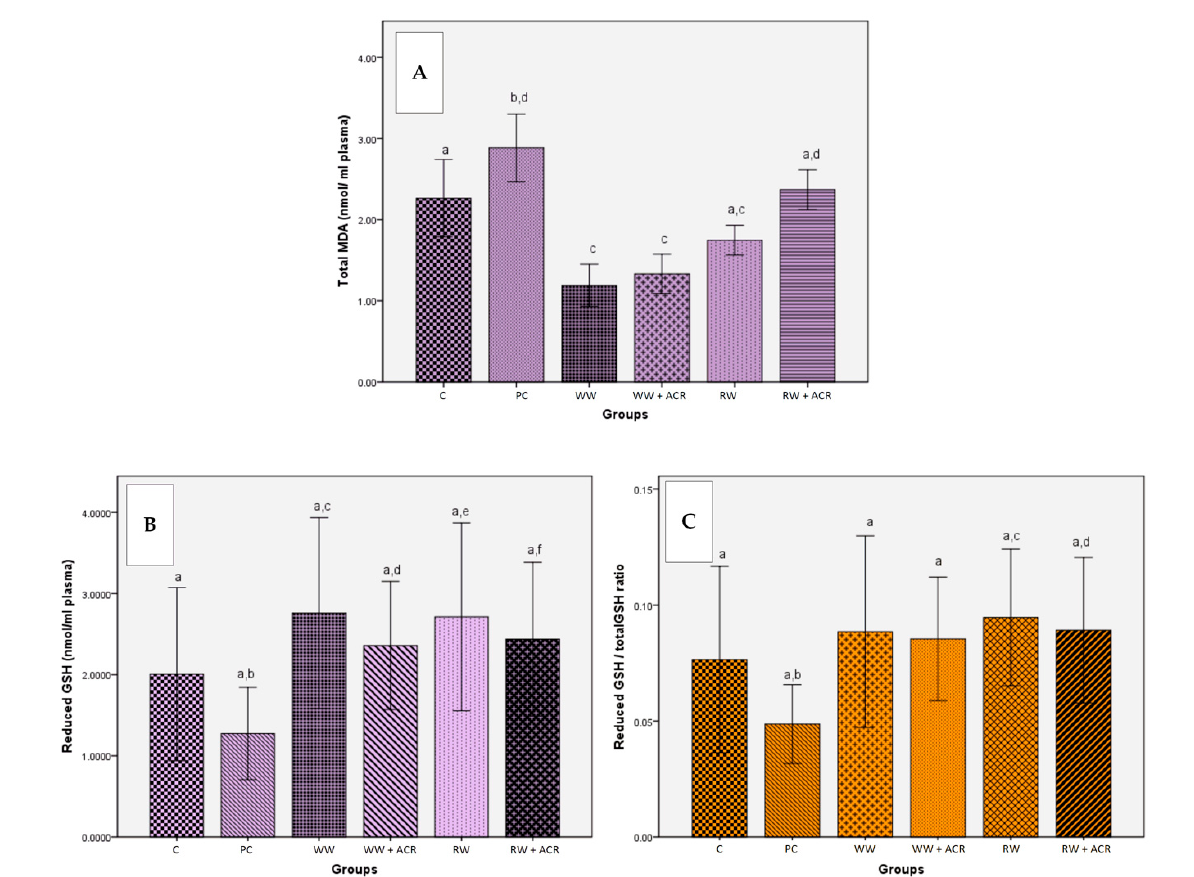
Figure 3. Effects of white/red wine on: total MDA plasma level (nmol/mL) ( A ), reduced GSH plasma level (nmol/mL) ( B ), and the reduced GSH/total GSH ratio ( C ) in rats from ACR-treated groups compared to untreated ones ( n = 10). Bars marked with the same letter do not differ significantly ( p < 0.05). C − hydroalcoholic solution group; PC − hydroalcoholic solution + acrylamide group; WW − white wine group; WW + ACR − white wine + acrylamide group; RW − red wine group; RW + ACR − red wine + acrylamide group.